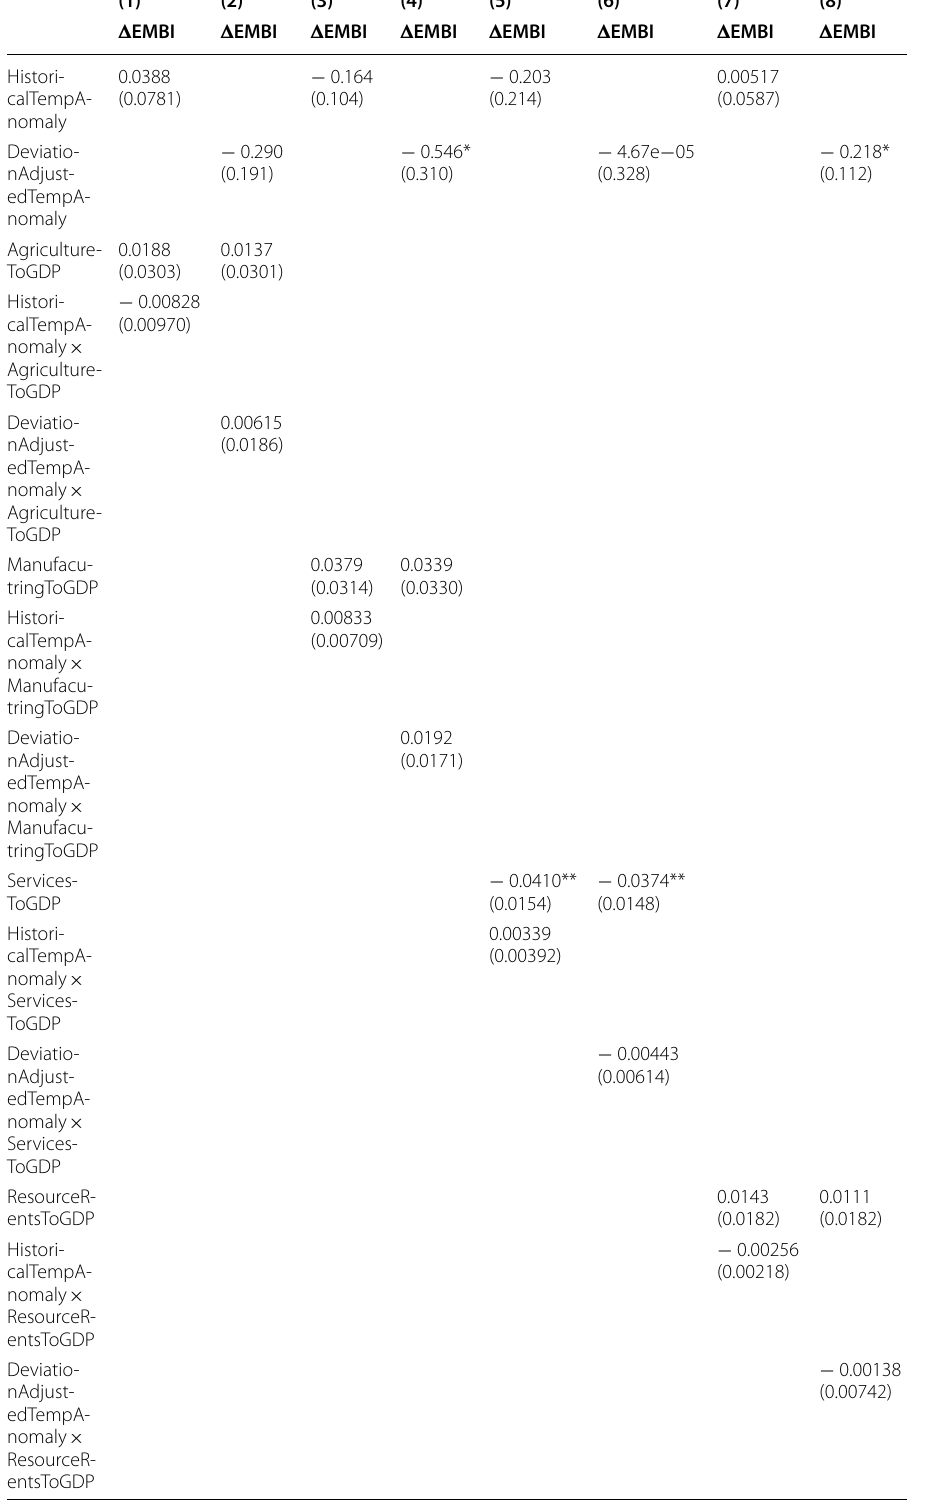
Table 8 Channels of temperature–sovereign risk connection: economic sector